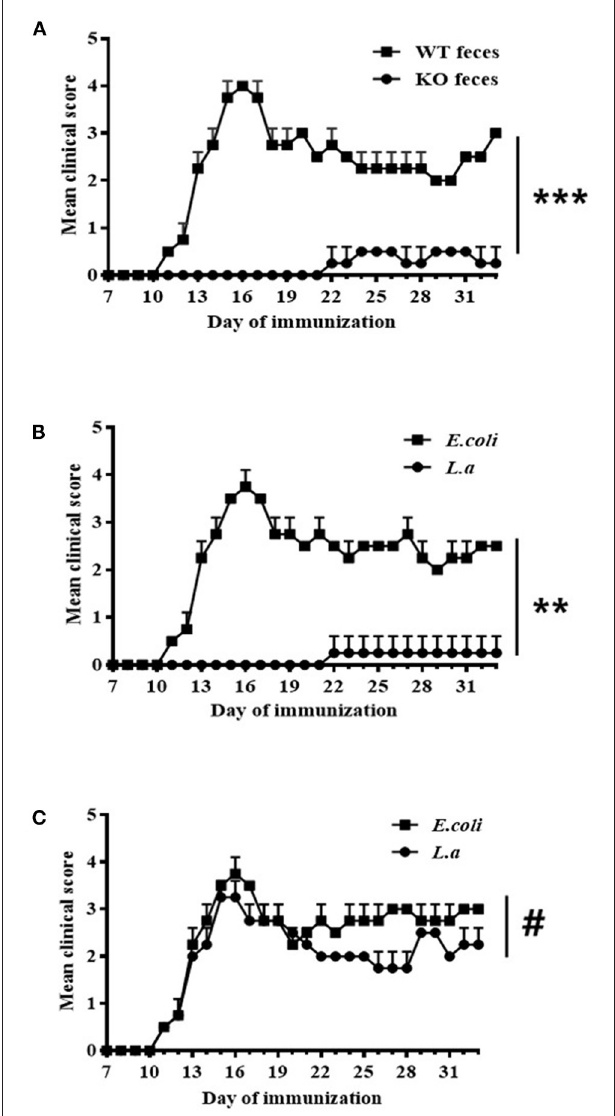
FIGURE 3 | L. acidipiscis induced resistance to EAE in susceptible mice. (A) Results showing feces of CD44KO mice having induced resistance to EAE in WT receptor mice (WT feces: WT mice with EAE and that received feces from WT mice, n = 5; KO feces: WT mice with EAE and that received feces from CD44KO mice, n = 5). (B) Results showing L. acidipiscis having induced resistance to EAE in WT mice ( E. coli : WT mice with EAE and that were fed E. coli , n = 5; L. a : WT mice with EAE and that were fed L. acidipiscis , n = 5). (C) L. acidipiscis did not produce resistance to EAE in TCR δ − / − mice ( E. coli